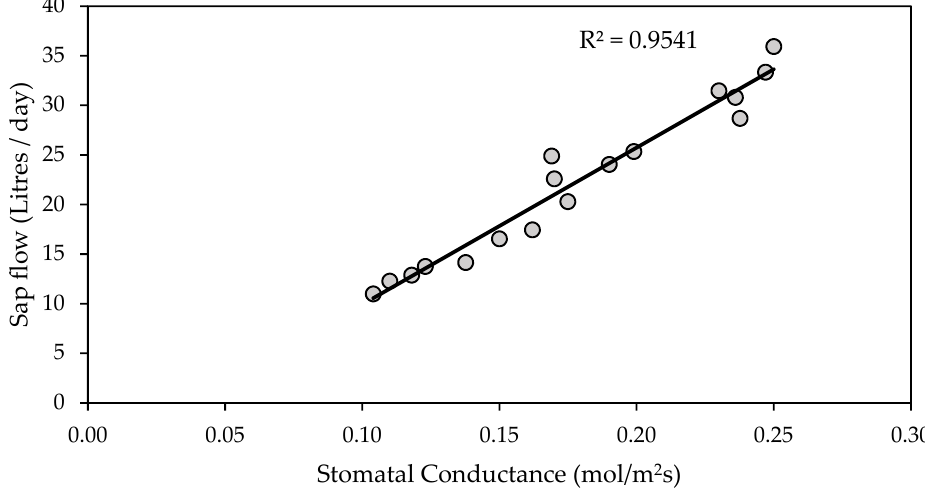
Figure 8. Measured sap flow per plant versus stomatal conductance.